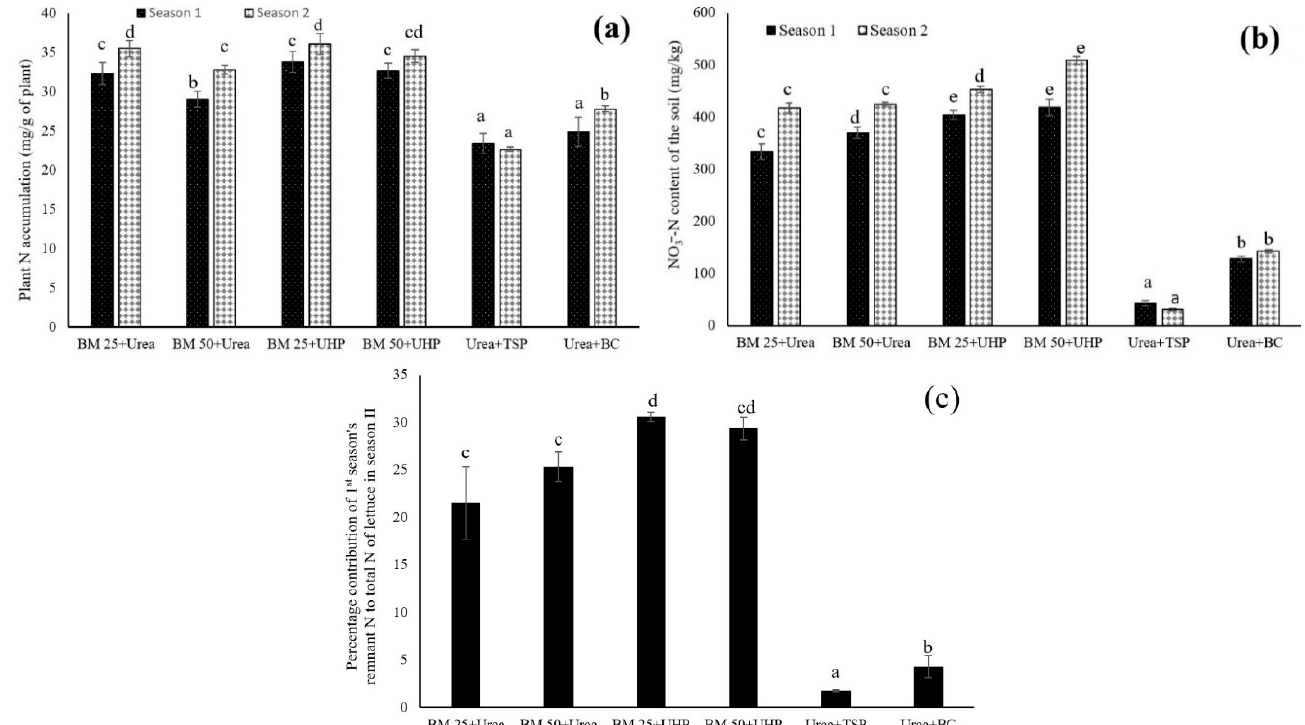
Figure 2. ( a ) The quantities of N accumulated into the leaf lettuce grown on the different amendments, ( b ) nitrate N contents of the soil under different amendments, ( c ) the percentage contribution of first season’s remnant N to the total N accumulated into the leaf lettuce in the 2nd season.